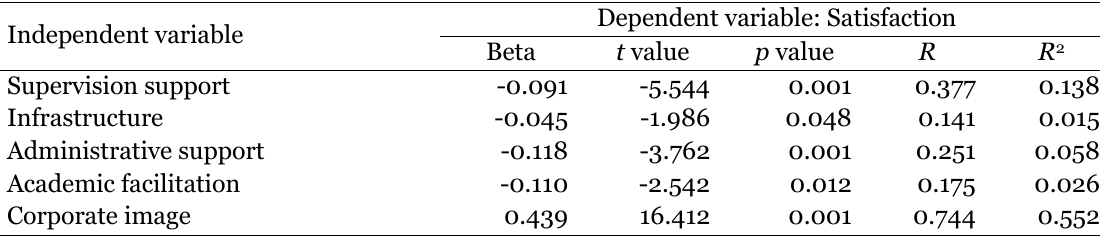
Dependent variable: Satisfaction Beta t value p value R R 2